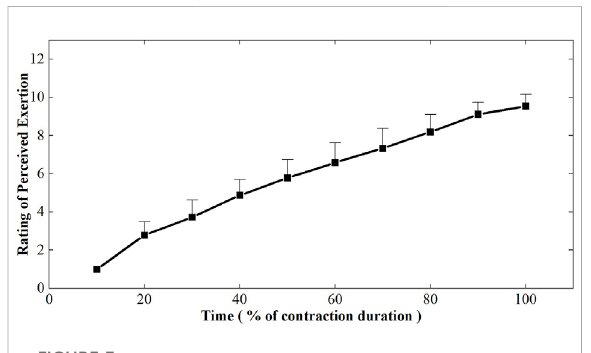
FIGURE 3 Changes of rating of perceived exertion plotted as a percentage of contraction time during the sustained fatiguing contraction. For each subject, data have been normalized relative to the initial values.